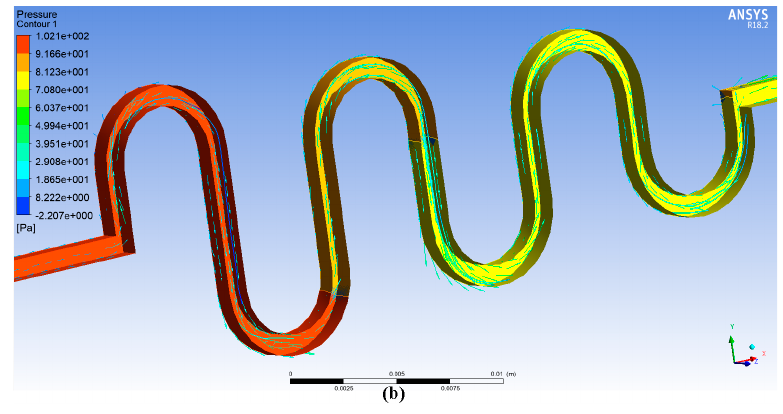
Figure 5. ( a ) Velocity contour plot; ( b ) Pressure contour plot for the descending sinusoidal microchannel (DSMC).